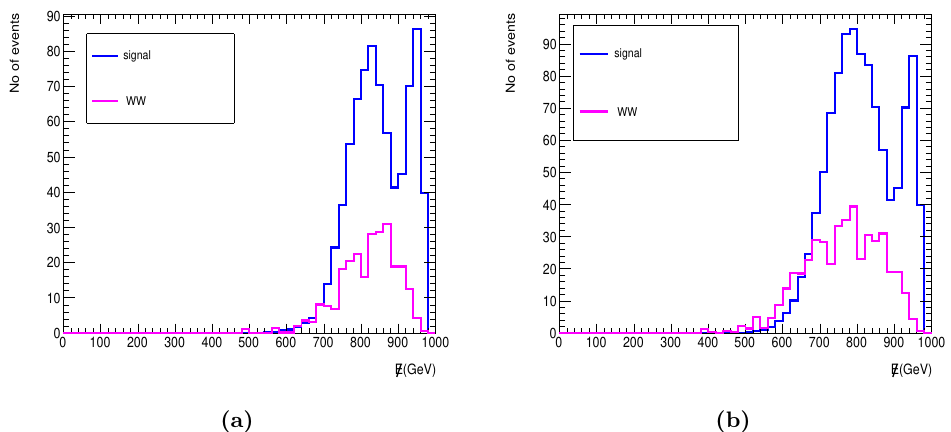
Figure 15. Signal (BP1) and SM background distribution after applying cuts (a) E ‘ √ and (b) E 200 GeV with s = 1 TeV for polarisation P3 (see text) at ‘ 1 <